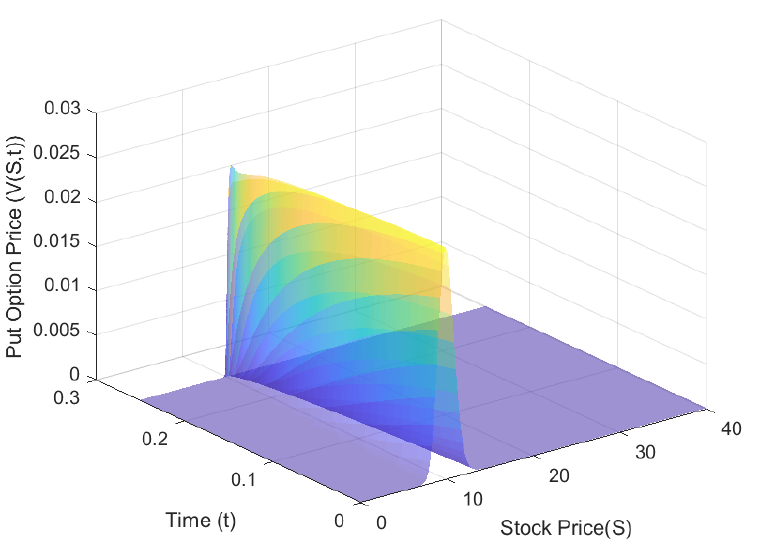
Figure 6. Barles and Soner model ( a = 0.02 ) vs. the linear model.